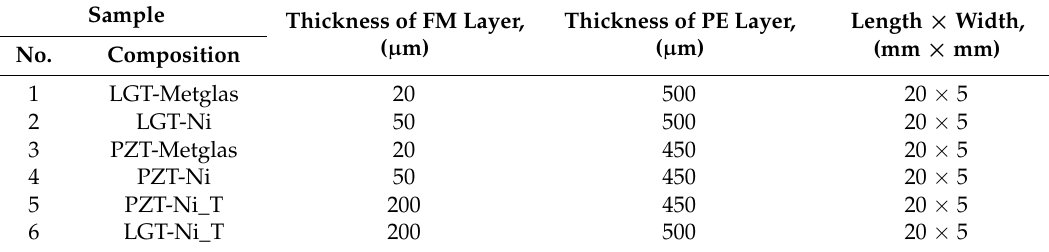
Table 2. Parameters of fabricated